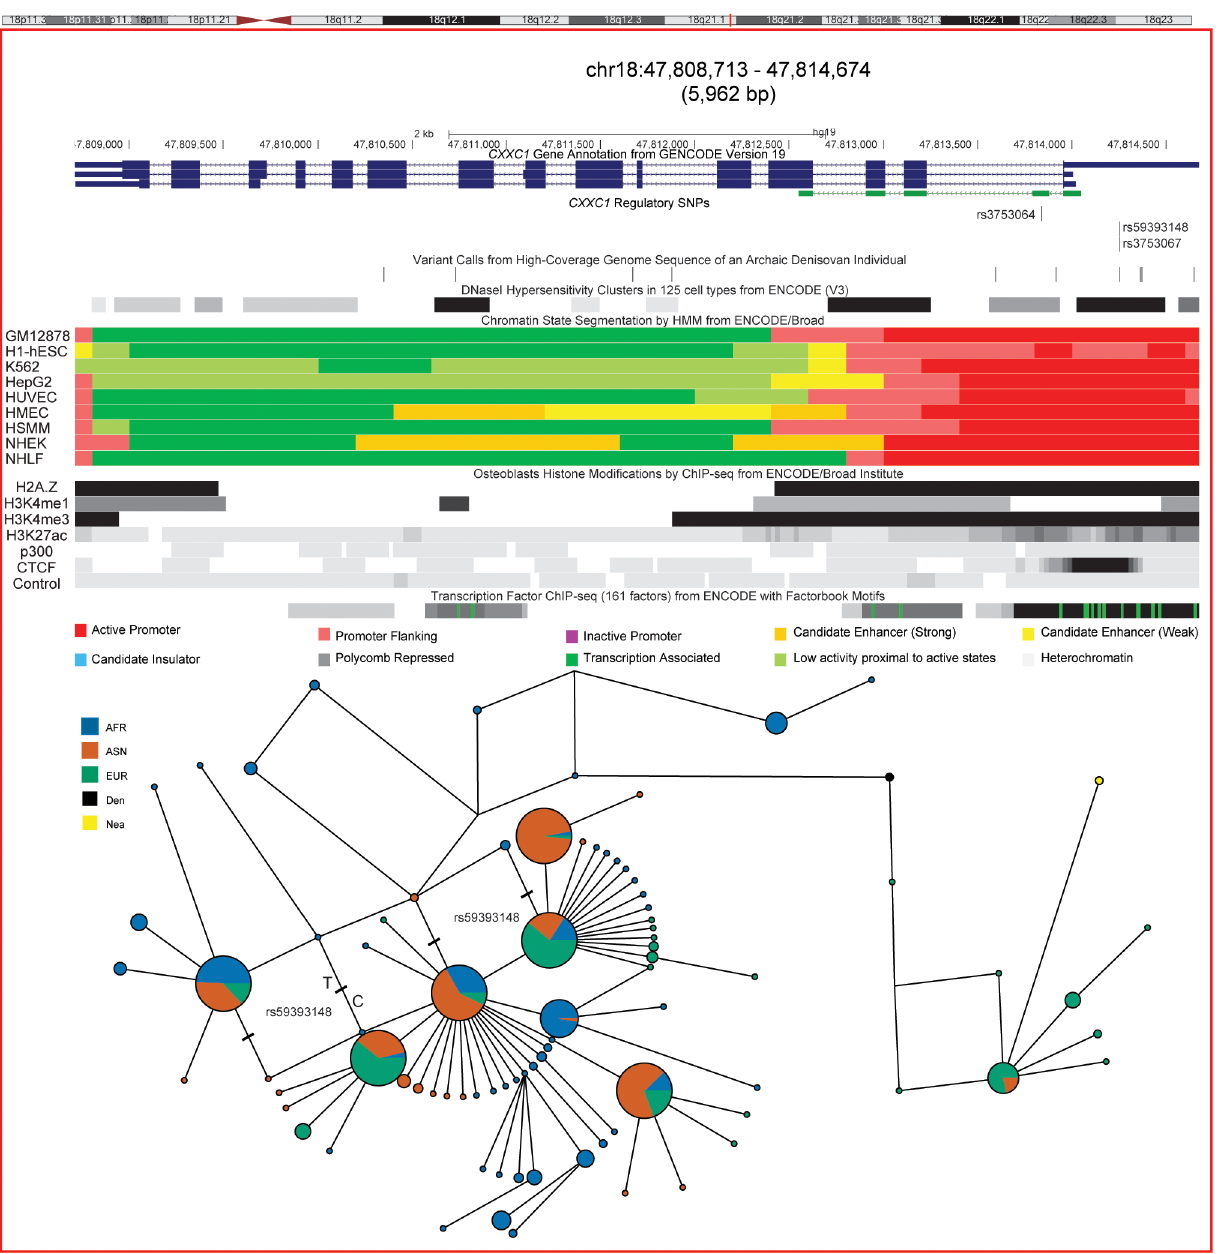
Fig 3. Positive selection at the CXXC1 locus. A ~6 kb region on chromosome 18 that spans CXXC1 showing GENCODE (Version 19) transcript annotation. The three short-listed candidate regulatory variants driving the selection signal in East Asians are all located in ENCODE annotated regions of open chromatin, depicted in the DNase I Hypersensitivity Clusters in 125 cell lines track, and show ENCODE chromatin state segmentation associated with an active promoter site in nine human cell lines. The latter include lymphoblastoids [GM12878]; embryonic stem cells [H1-hESC]; chronic myelogenous leukemia [K562]; hepatocellular carcinoma [HepG2]; umbilical vein endothelial [HUVEC]; mammary epithelial [HMEC]; skeletal muscle myoblast [HSMM]; skin epidermal keratinocytes [NHEK] and lung fibroblasts [NHLF]). Positions of histone modifications in osteoblasts are indicated by shaded bands and the black shade signifies enrichment. In osteoblasts the position of the histone sequence variant, H2A.Z, that determines accessibility of the transcription start site (TSS) and histone modifications like H3K4me3 that are enriched around TSS (dark bands) encompasses the candidate regulatory variant site and show binding for many transcription factors. H3K4me1 and H3K27ac modifications and p300 marks are enriched around active enhancers and CTCF indicates insulator regions. The lower part of the figure shows median joining haplotype networks in this region that is in high LD (r 2 (cid:3) 0.95) in CHB. Phased haplotypes generated by the 1000 Genomes Project were used to construct this network. The derived C allele for the regulatory variant rs59393148 lies on the branch leading towards the most frequent haplotype found in East Asians, and shows a star like expansion typical of a selection signal. Note the proximity of archaic human haplotypes with a subset of East Asian (ASN) and European Finnish samples. These samples lie on a divergent branch that is closer to the Neanderthal (Nea) and Denisovan (Den) haplotype when compared with the rest of the modern human population samples. doi:10.1371/journal.pone.0146072.g003 PLOS ONE | DOI:10.1371/journal.pone.0146072 December 31,